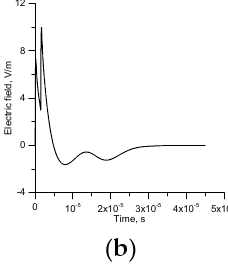
Figure 13 . The effect of multiple streamer bursts arising from the same origin on the NBP. In the simulation, the growth parameters of each streamer burst is assumed identical to the one used previously except that the value of n 0 was selected to make the peak of the NBP equal to 10 V / m at 100 km. ( a ) separation between streamer bursts 1.0 μ s; ( b ) separation between streamer bursts 1.5 μ s.